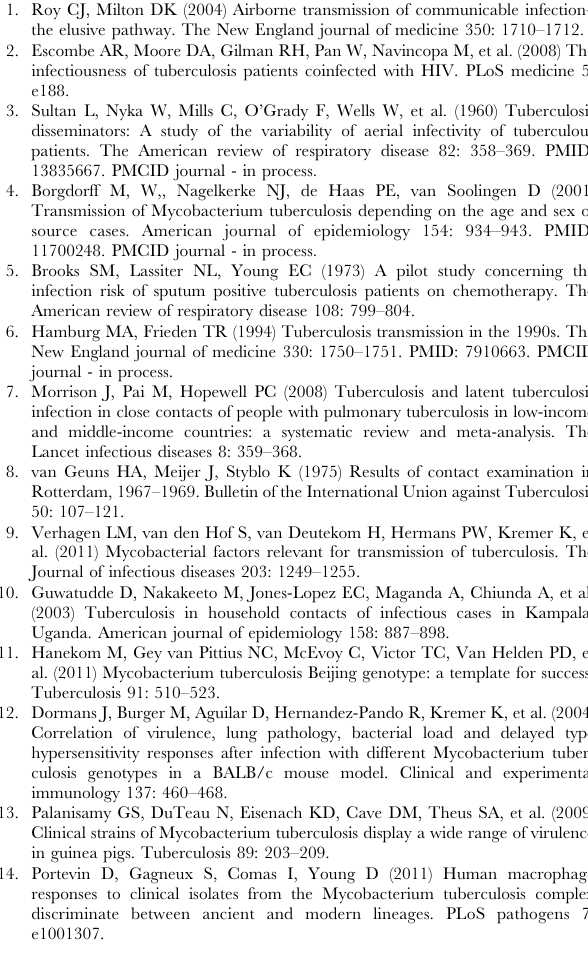
Table S1 Additional characteristics of index tuberculo- sis cases, household contacts, and study dwellings at baseline by Mycobacterium tuberculosis